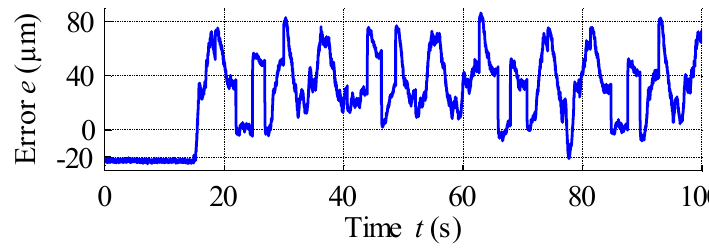
Figure 18. Linearised characteristics of the MSMA actuator.